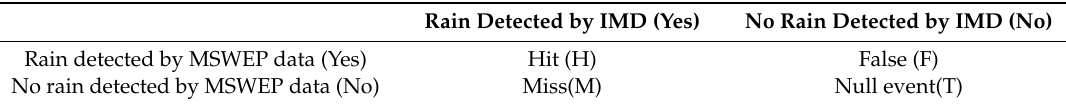
Table 1. Contingency table for comparing MSWEP with IMD rain gauge data. Rain Detected by IMD (Yes) No Rain Detected by IMD (No) Rain detected by MSWEP data (Yes) Hit (H) False